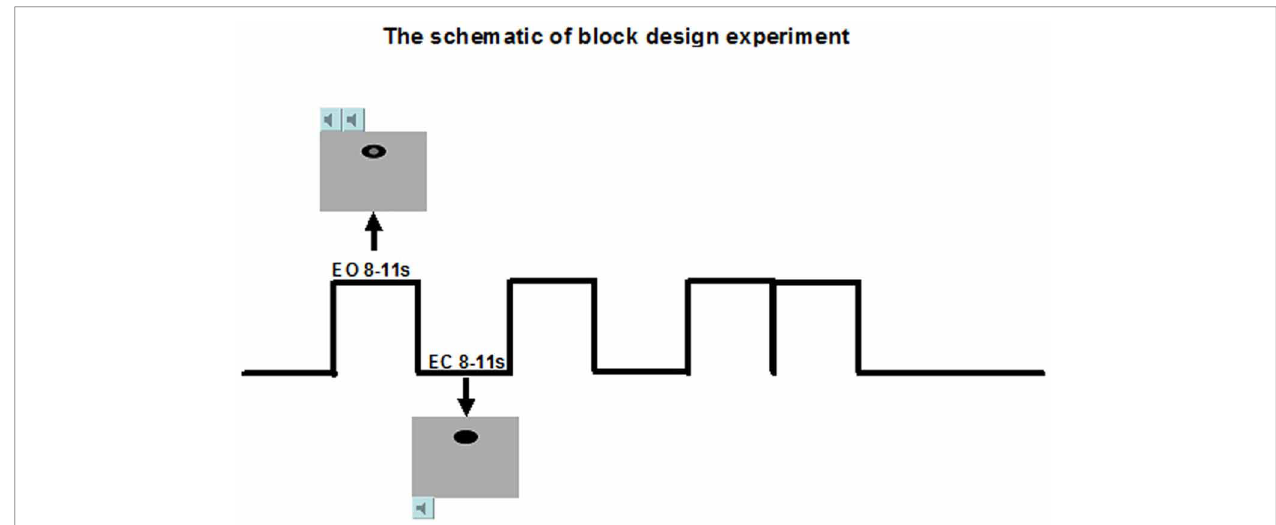
FIGURE A1 | Schemata of block-design experiment. The first block-design experiment included eyes open and eyes closed blocks with duration from 8 to 11s. The EC and EO blocks were pseudo-randomlypresented. Ahead of each EC block, a single tone was presented to the participants; Ahead of the EO block, double tones were presented to the participants. During the EC